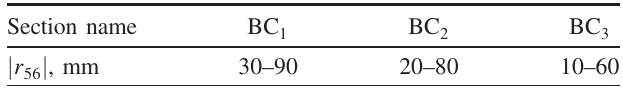
TABLE II. Range of momentum compaction factors in the bunch